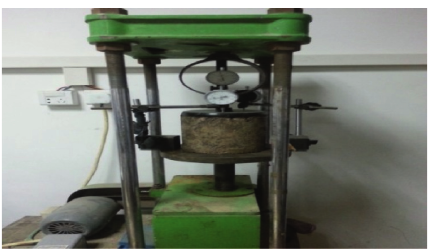
Figure 5: Pavement material shrinkage deformation tester.